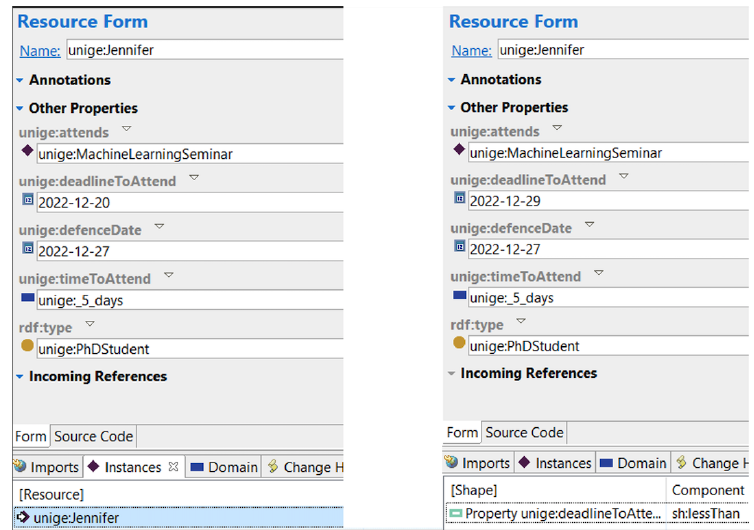
Figure 8: The instantiation of SHACL-based Rule Advanced scientific seminar (pass and fail